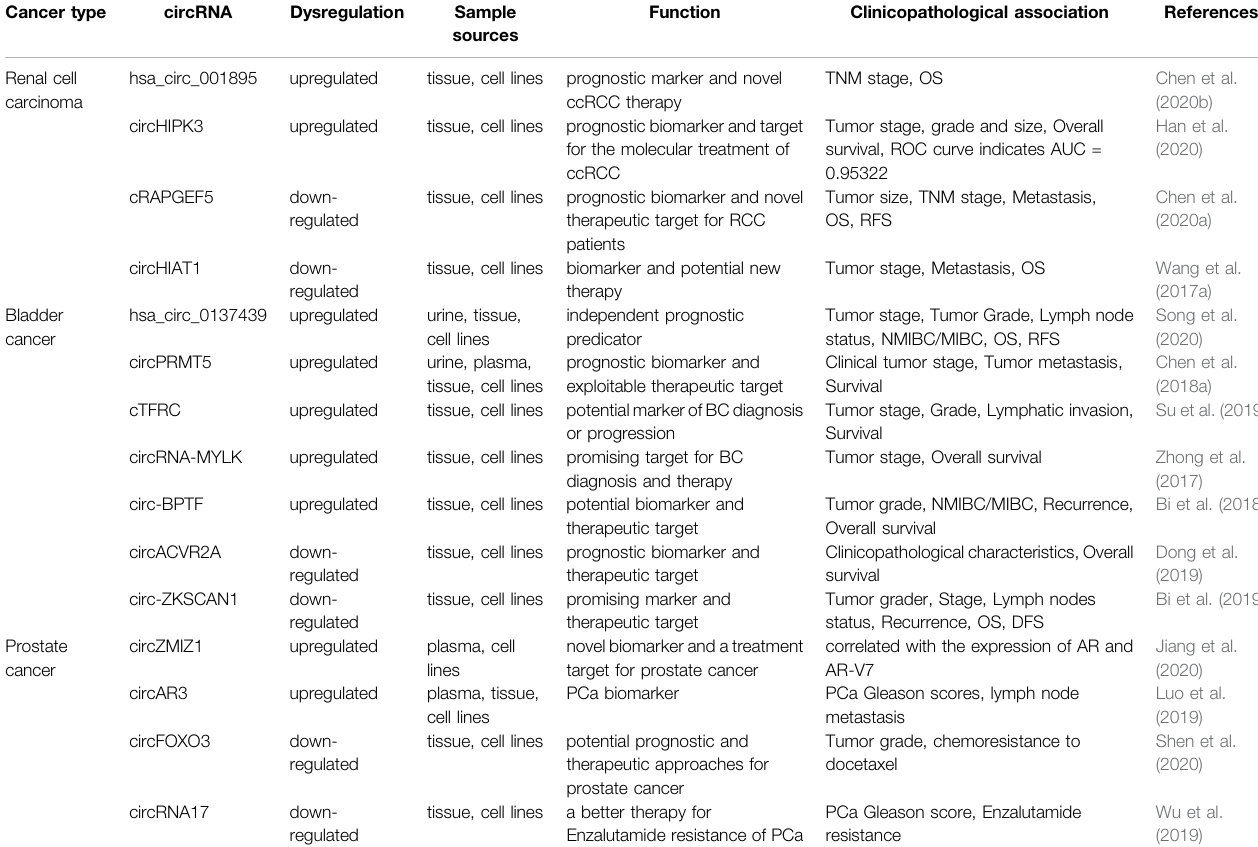
TABLE 1 | CircRNAs act as biomarkers and therapeutic targets in urological